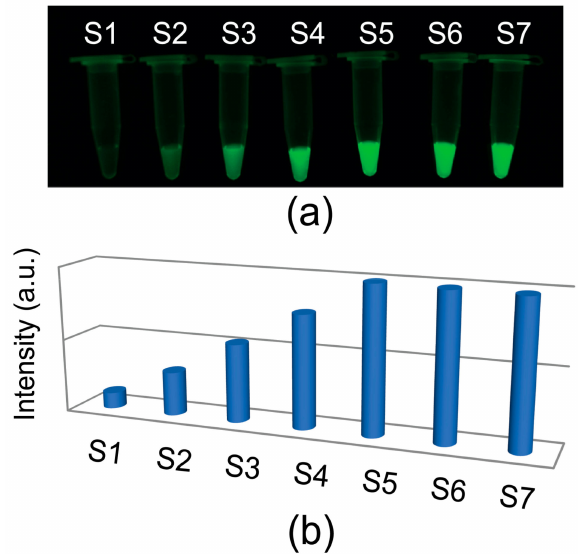
Figure 3. ( a ) A photo for fluorescence image under UV light excitation for various FAM concentrations; ( b ) relative intensities of fluorescence from the corresponding FAM concentrations (S1–FS7 correspond to FAM concentrations, i.e., 5, 10, 15, 20, 25, 30, and 35 nM,